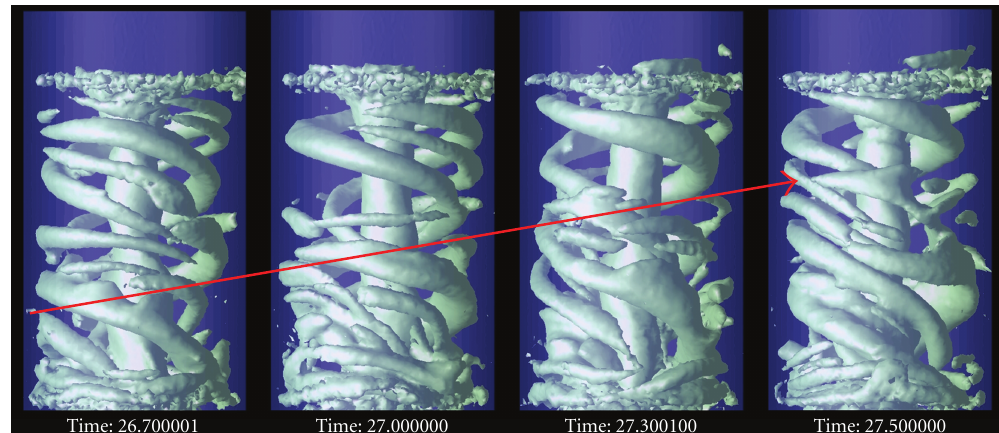
Figure 10: Upwards movement of the secondary structures.